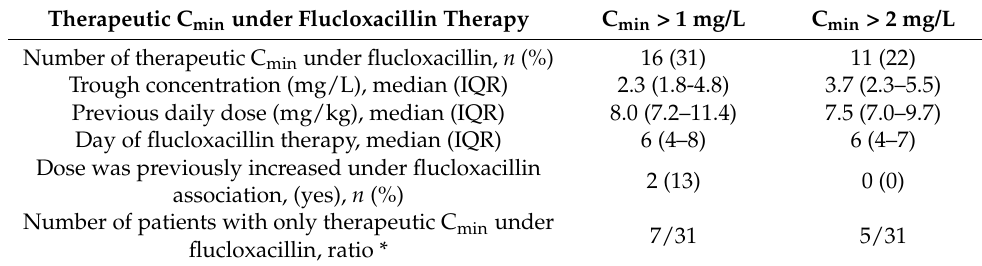
Table 2. Therapeutic voriconazole trough concentrations under flucloxacillin